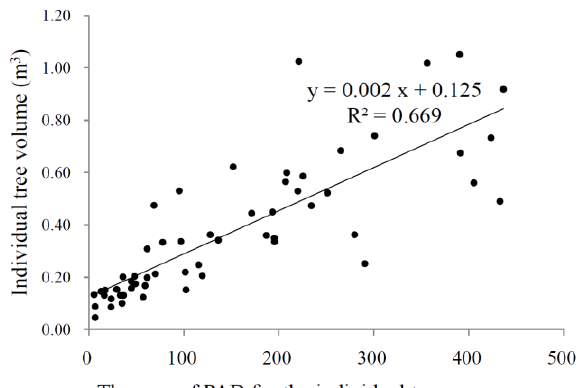
Figure 5. Relationship between volume and sum of PAD for the individual trees In the point-clouds data (bottom blocks in Fig. 4), there seems to be little difference in the numbers of laser returns at between the upper crowns and lower crowns. But in the PAD estimation (the middle blocks of Fig. 4), the PAD values in upper crowns are mostly less than those in lower